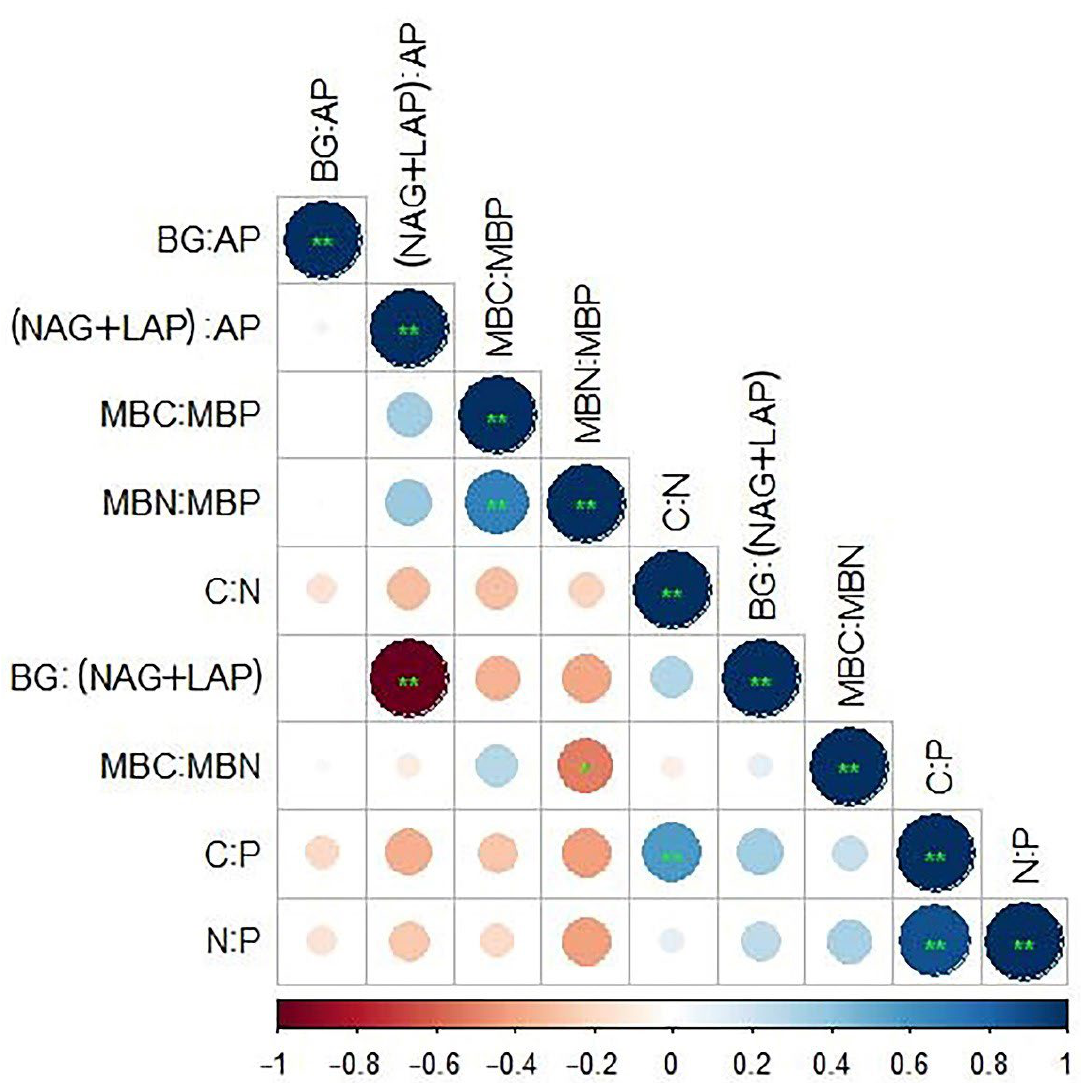
Figure 6. Correlations of soil element, microorganism, and extracellular enzyme C:N:P of Z. planispinum plantations. C:N, soil C:N ratio; C:P, soil C:P ratio; N:P, soil N:P ratio; MBC:MBN, soil microbial biomass carbon to microbial biomass nitrogen ratio; MBC:MBP, soil microbial biomass carbon to microbial biomass phosphorus ratio; MBN:MBP, soil microbial biomass nitrogen to microbial biomass phosphorus ratio; BG:(NAG + LAP), ratio of β -1,4-glucosidase to the sum of β -1,4-n-acetylglucosaminidase and leucine aminopeptidase; BG:AP, β -1,4-glucosidase to acid phosphatase ratio; (NAG + LAP):AP, ratio of the sum of β -1,4-n-acetylglucosaminidase and leucine aminopeptidase to acid phosphatase. *, ** indicates significant differences at p < 0.05 and p < 0.01, respectively. Table 3. Standardized major axis analysis of C, N, and P concentrations in soil and soil microbial biomass. Variable n r